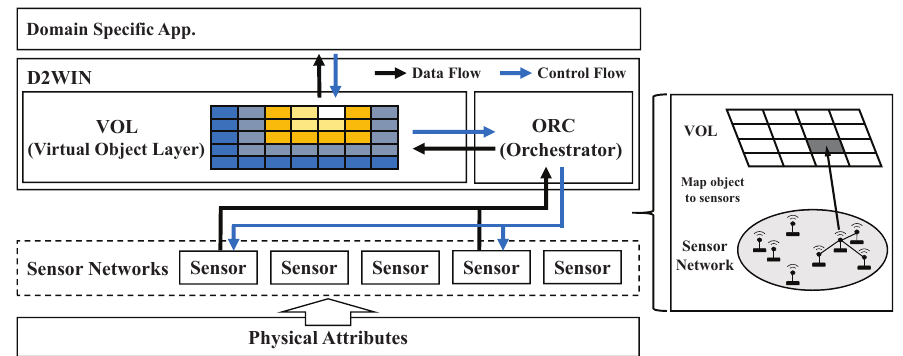
Figure 3. Conceptual system architecture for sensor data management: The D2WIN framework acts as a mediator between a domain-specific, data-intensive application, and a network system with multiple